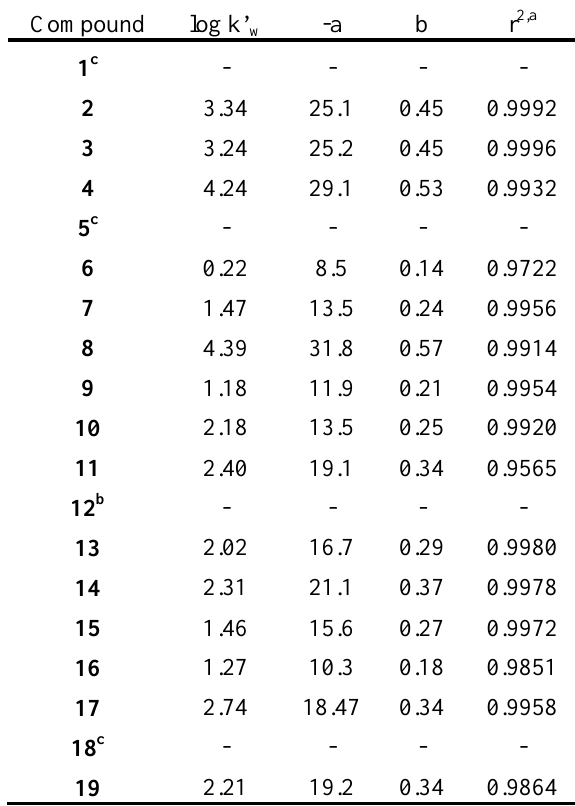
Table 2: Retention model parameters from equation 2 for the studied N -oxide derivatives. Compound log k’ -a b r 2,a w 1 c -